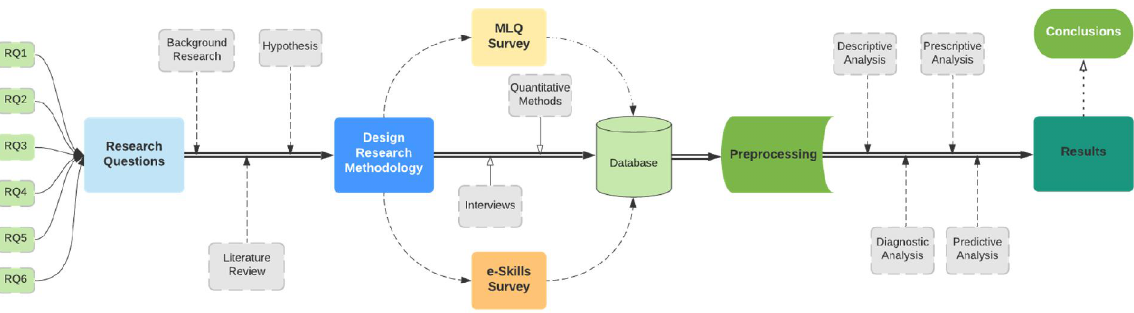
Figure 3. Flowchart of Research